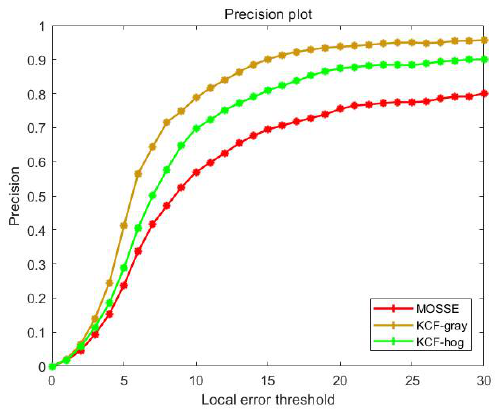
Figure 7. Precision plot for pupil tracking.